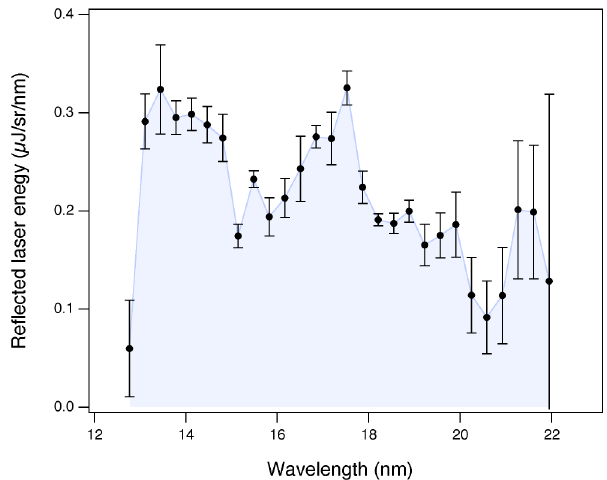
Figure 16. Spectrum of the radiation reflected by the relativistic flying